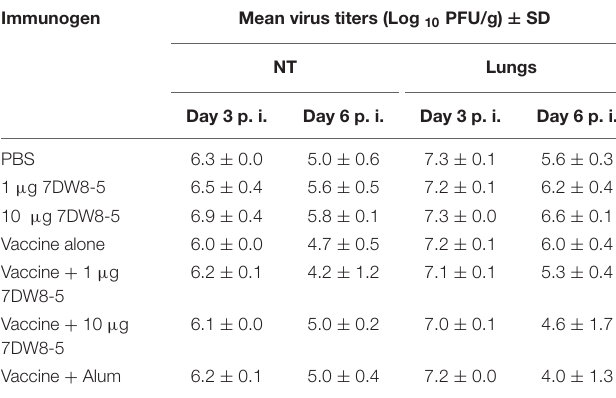
TABLE 1 | Virus replication in the respiratory tract of immunized mice challenged with MA-CA04 virus a .